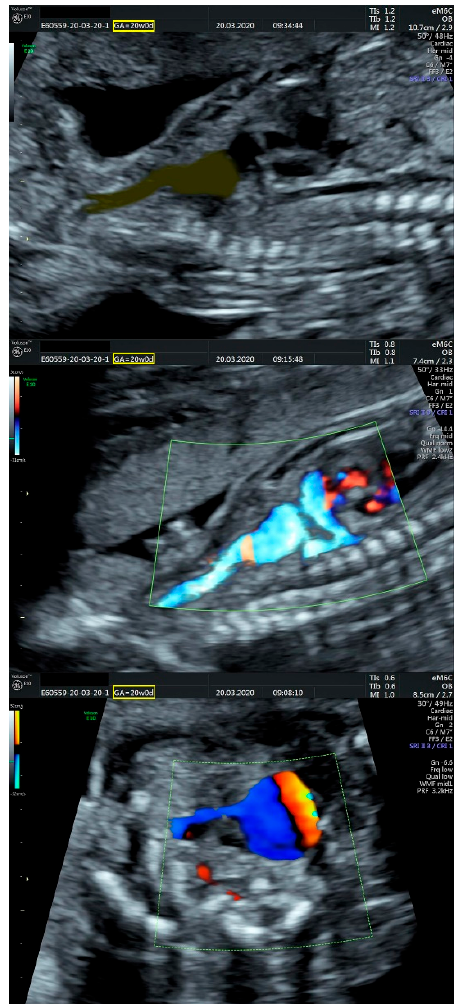
Figure 6. ( Top and middle ): sagittal section and Doppler examination of the aneurysm and the vascular pattern which bifurcates towards the cervical region; ( bottom ): turbulent Doppler flow highlighting the communication between the aneurysm and pulmonary trunk/left pulmonary artery .